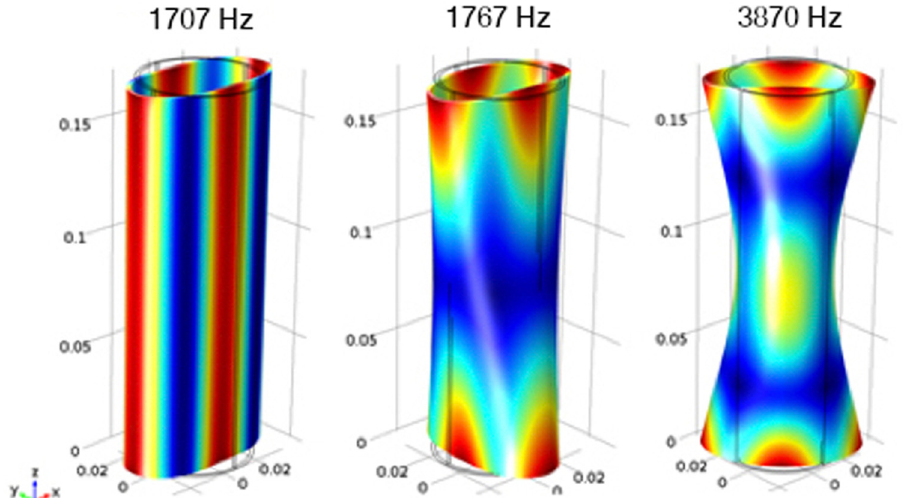
Figure 15: Simulations of the natural frequency for pipe sleeves.